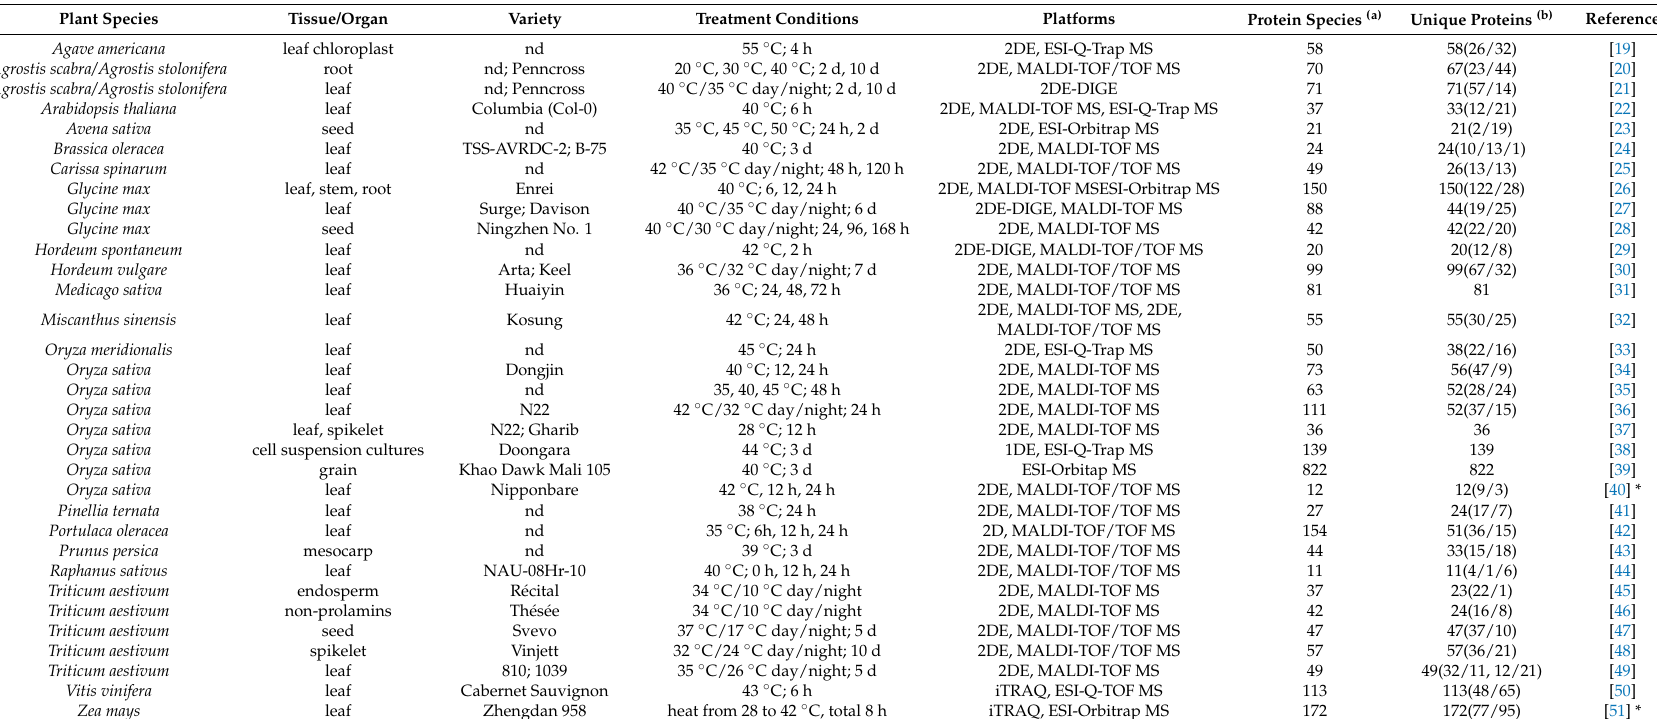
Zea mays iTRAQ, ESI-Orbitrap MS 172 172(77/95) [51] * (a) The number of identified protein identities included all the protein isoforms generated from gene variable splicing and post-translational modifications in these original publications. (b) The number of non-redundant protein identities whose members have similar protein sequence homology and functional domain (increased protein number/decreased protein number). The references labeled with * are phosphoproteomic studies. The information of these heat-responsive proteins is listed in Tables S1 and S2. 2DE, two-dimensional electrophoretic; d, days; DIGE, two-dimensional fluorescence difference in gel; ESI-Q-TOF MS, electrospray ionization quadrupole time-of-flight mass; iTRAQ, isobaric tags for relative and absolute quantitation; MALDI-TOF MS, matrix-assisted laser desorption/ionization time-of-flight mass; MALDI-TOF/TOF MS, matrix-assisted laser desorption/ionization tandem time-of-flight mass; nd, not